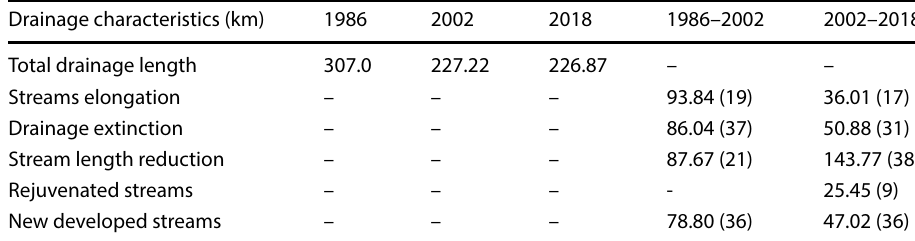
Table 3 Morphometric characteristics of the drainage system in Akure in 1986, 2002 and 2018 (Number of streams is in parenthesis)